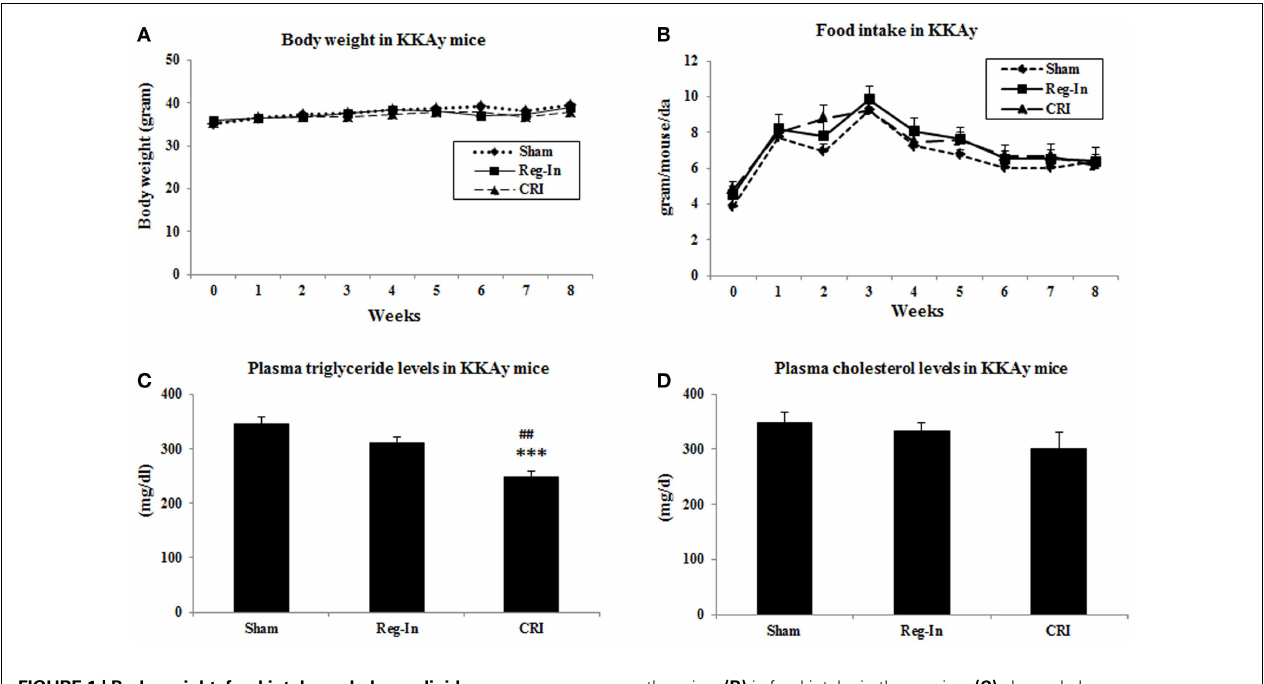
FIGURE 1 | Body weight, food intake and plasma lipids concentrations in Sham, Reg-In, and CRI treated mice . Body weight and food intake of mice were recorded weekly. Fasting plasma lipid concentrations were measured at week 7. (A) Showed body weights in